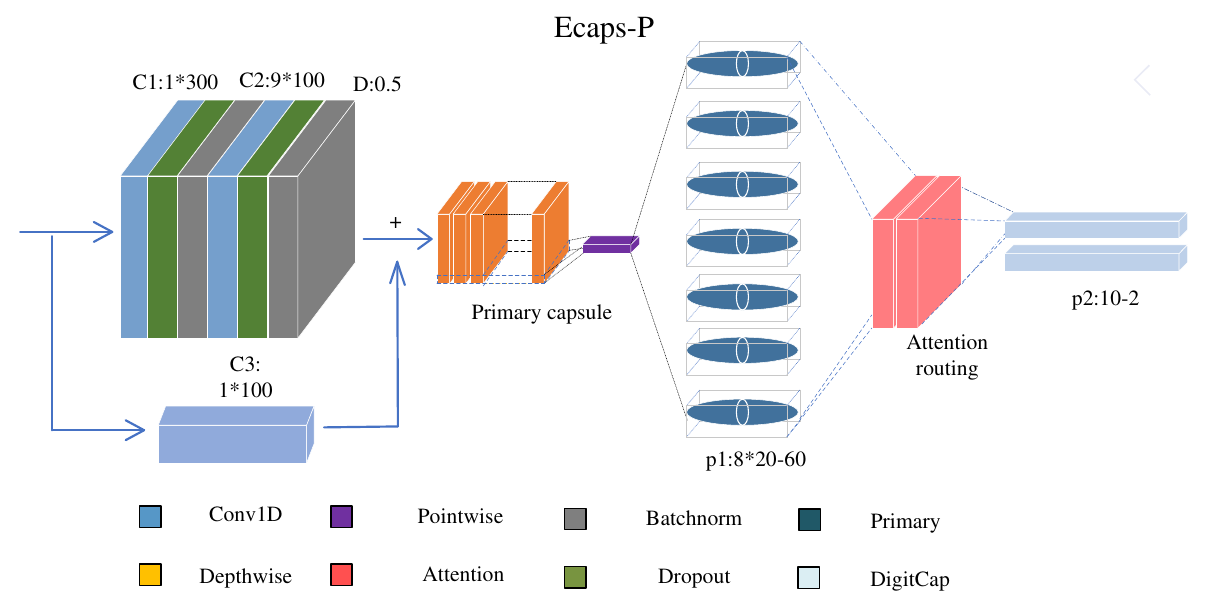
Figure 6. The novel capsnet architecture consists of CNN and self-attention routing. The CNN is used to extract high-level motif features containing interconnections and mutual position relationships among features. The BatchNorm layer and dropout layers are interspersed in the CNN to solve the overfitting problem. The self-attention layer is used to obtain remote dependencies between residues in protein sequences